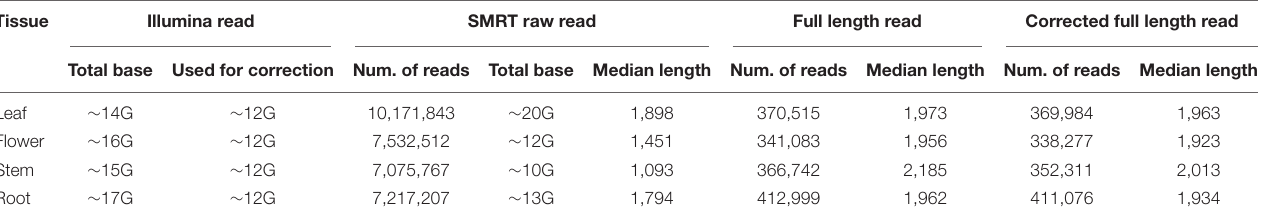
TABLE 1 | Summary of the sequencing libraries statistics of next generation sequencing (NGS) and third generation transcriptome sequencing (TGS) data in leaf, flowers, stem and root in A. annua. Tissue Illumina read SMRT raw read Full length